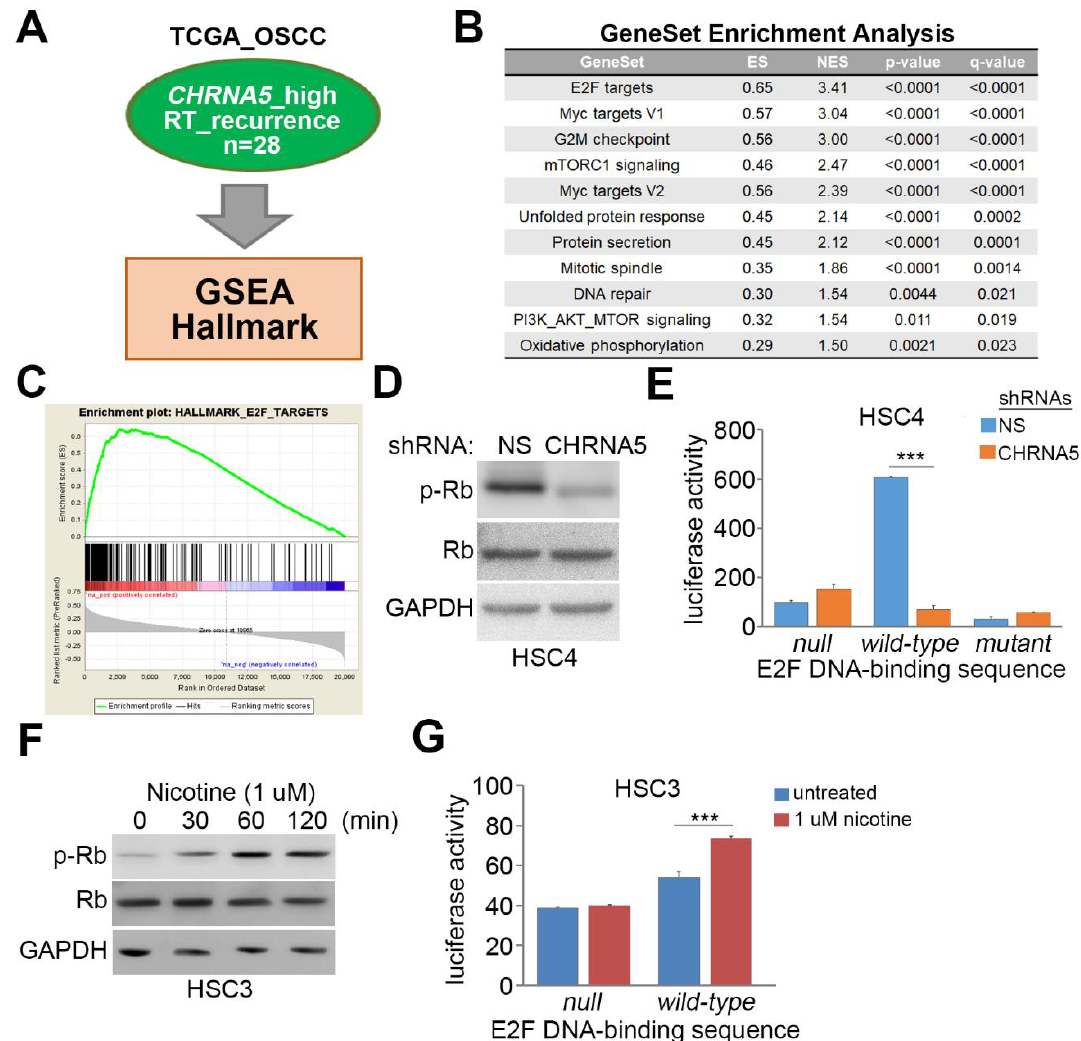
Figure 4. CHRNA5 activation triggers E2F activity in OSCC cells. ( A ) Flowchart of gene